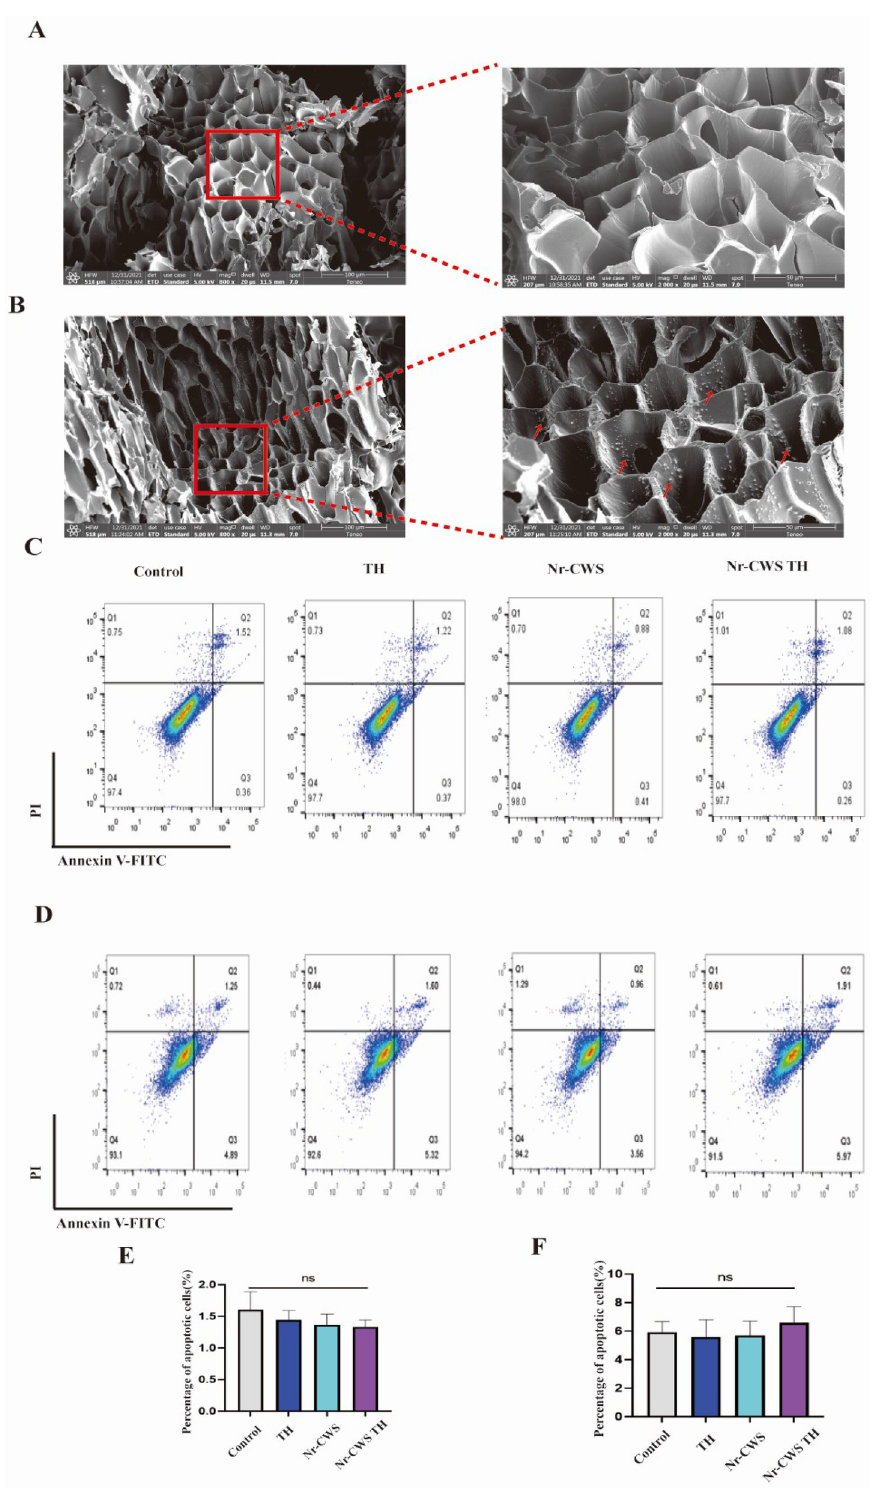
Fig 2. The continuous release of N-CWS from N-CWS TH hydrogel in vivo and vitro. Three-dimensional structure and safety of hydrogel A,B) The microstructure and safety of TH-hydrogel with/without N-CWS. The red arrow indicates the loaded N-CWS. Scale bar = 100 μ m and Scale bar = 50 μ m; C-F) The survival rate of HUVEC cells (C,E) and fibroblast cells (D,F) treated with/without N-CWS and TH using PI/annexin V-FITC staining and statistical results of early apoptosis rate. (n. s,